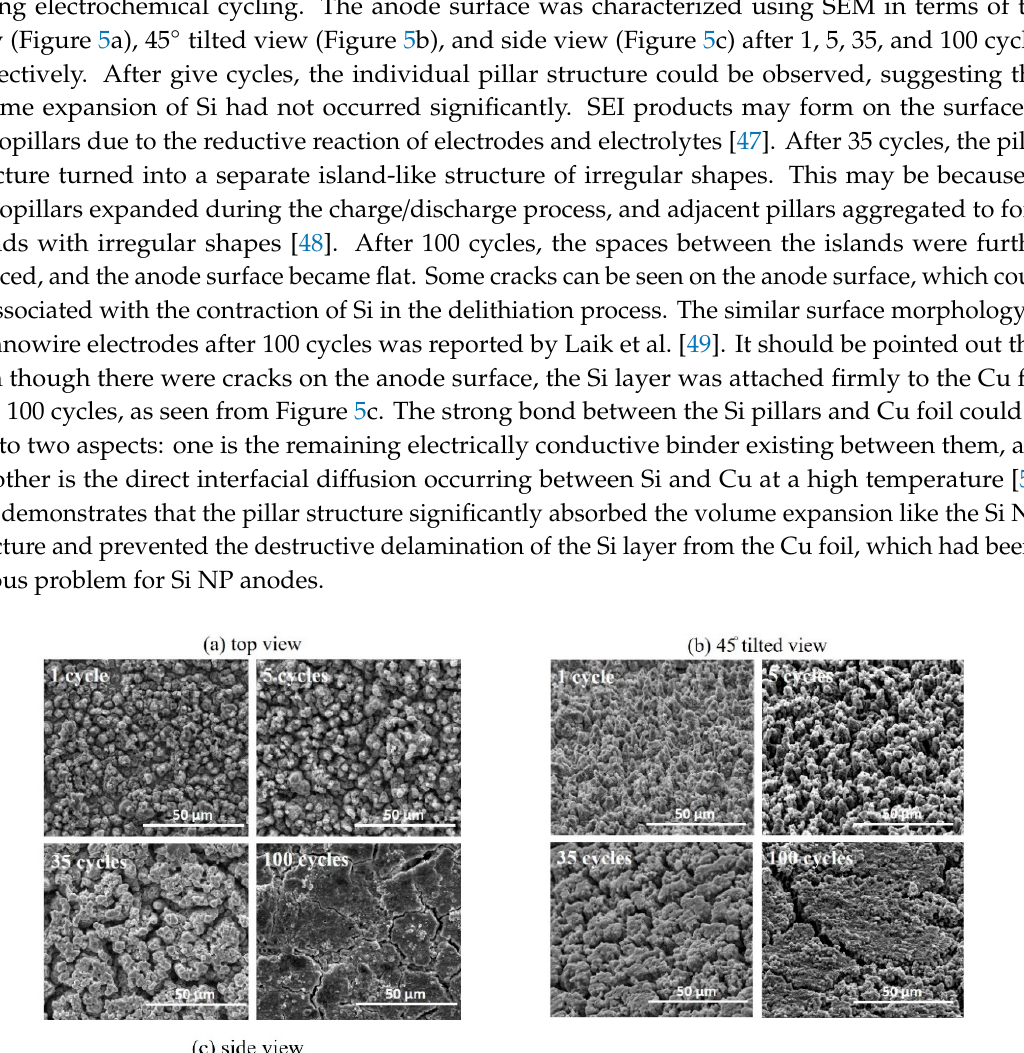
Figure 5. SEM images of Si micropillars after a varying number of cycles from ( a ) top view; ( b ) 45° tilted view; ( c ) side view. ( d ) Thickness of Si anode measured from ( c tilted view; ( c ) side view. ( d ) Thickness of Si anode measured from ( c ).